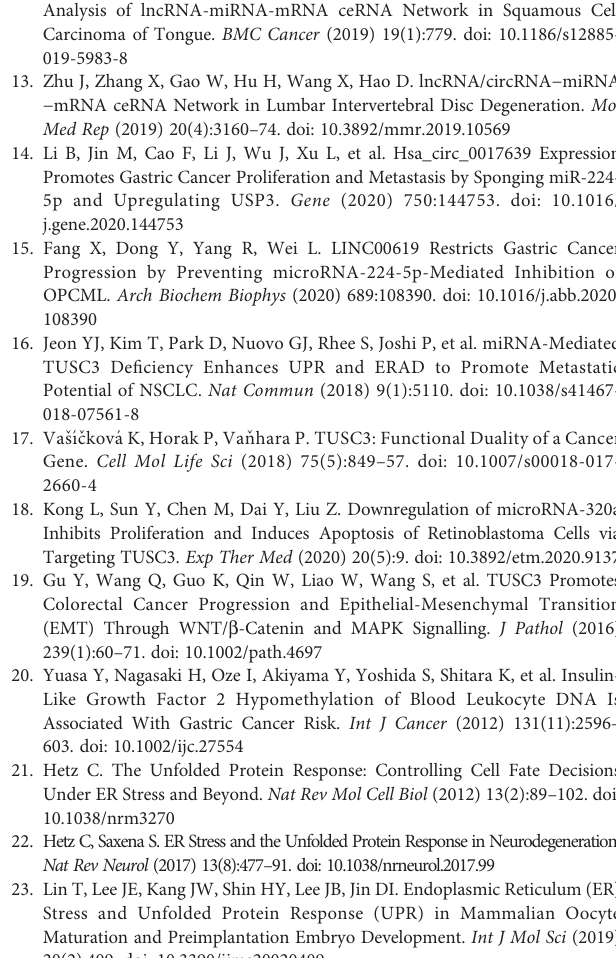
Supplementary Figure 2 | Analysis of the correlations of miR-224-5p and the clinical characteristics in GC patients by Real-Time qPCR. Each experiment contained 3 repetitions, and P < 0.05 were marked by "*". Supplementary Figure 3 | Analysis of the correlations of TUSC3 mRNA and the clinical characteristics in GC patients by Real-Time qPCR. Each experiment contained 3 repetitions, and P < 0.05 were marked by "*". Supplementary Figure 4 | LncRNA MIR503HG, miR-224-5p and TUSC3 were downregulated and overexpressed in GC cells, examined by Real-Time qPCR analysis. Each experiment contained 3 repetitions,and P < 0.05 weremarked by "*". Supplementary Figure 5 | Real-Time qPCR was used to determine that ATF6, PERK and IRE1 were successfully deleted in the GC cells. Each experiment contained 3 repetitions, and P < 0.05 were marked by "*". Supplementary Figure 6 | RNA pull-down assay was performed to verify the targeting sites amongLncRNAMIR503HG,miR-224-5pand3 ’ UTRofTUSC3inGC cells. Each experiment contained 3 repetitions, and P < 0.05 were marked by "*". Supplementary Figure 7 | The regulating effects among LncRNA MIR503HG, miR-224-5p and TUSC3 were measured by Real-Time qPCR analysis. The regulating effects of LncRNA MIR503HG on (A) miR-224-5p and (C) TUSC3 mRNA expressions. MiR-224-5p was overexpressed and downregulated, and its effects on (B) LncRNA MIR503HG and (D) TUSC3 mRNA were evaluated. Each experiment contained 3 repetitions, and P < 0.05 were marked by